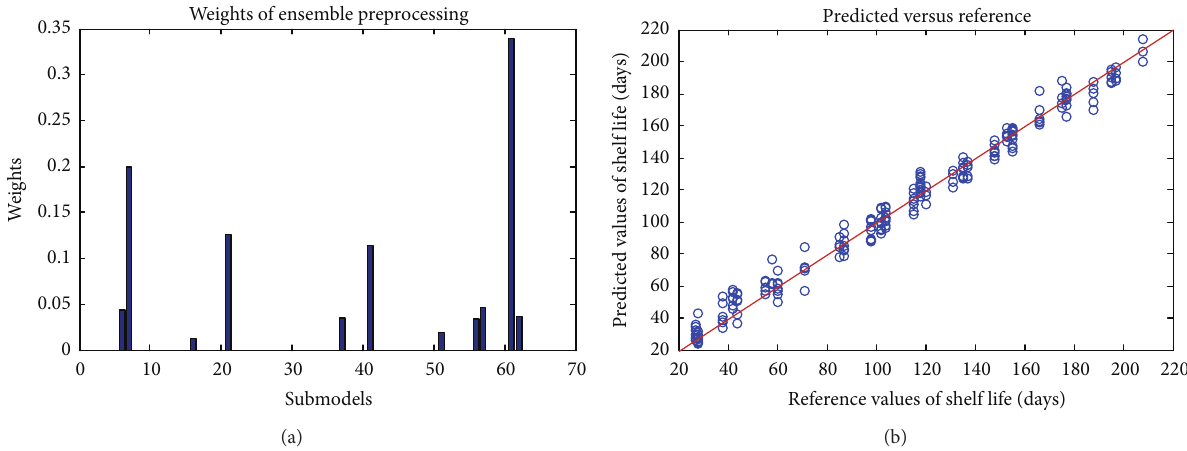
Figure 3: Submodel weights and predicted results obtained by stacking LS-SVM with ensemble preprocessing.